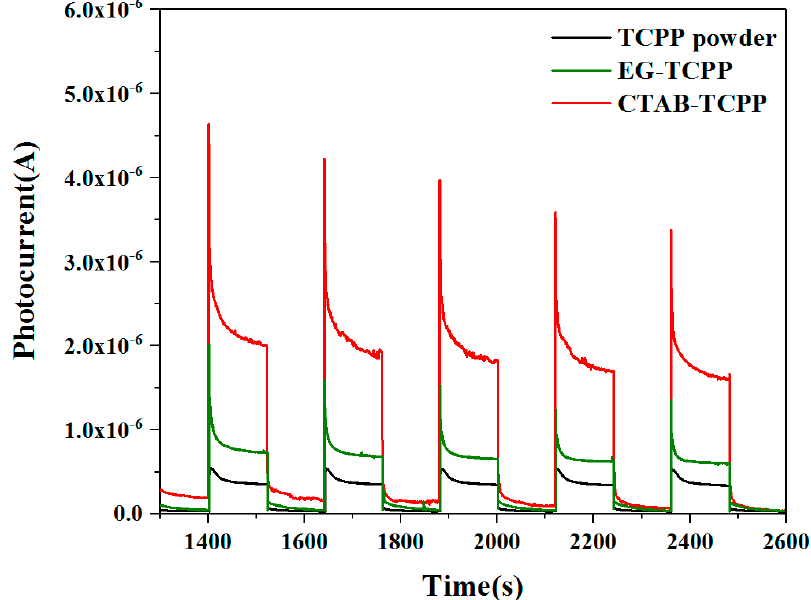
Figure 11. Transient photocurrent response spectra of the different TCPP aggregates.